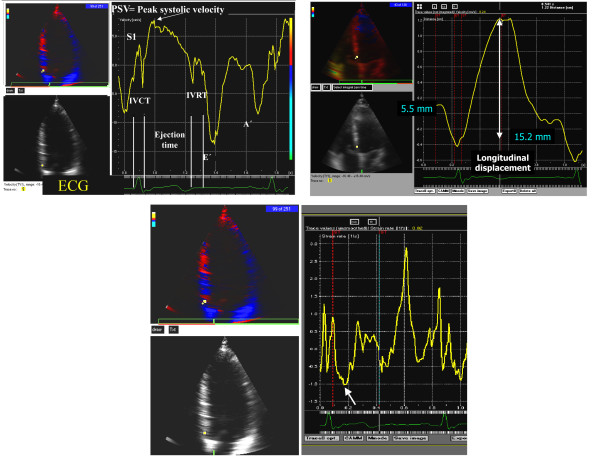
Upper left: A typical color-Doppler velocity profile obtained by positioning the sample volume in the septum base. S1 = isovolumic contraction velocity in the first positive peak, PSV = peak systolic velocity. IVCT and IVRT respectively are isovolumic contraction and relaxation times, E'and A'are respectively early and late diastolic velocities. The velocity profile is accompanied by an ECG signal. Upper right. A systolic displacement image, obtained by integration of the respective velocity profile during systole that provides amplitude of total displacement (usually ≥ 12 mm in healthy individuals). Lower panel. Strain rate imaging in which the white arrow indicates peak systolic strain rate obtained by spatial differential of velocities at two points divided by the distance between them. In our laboratory the insonation distance of approximately 15 mm provides a favorable signal-to-noise ratio [27].